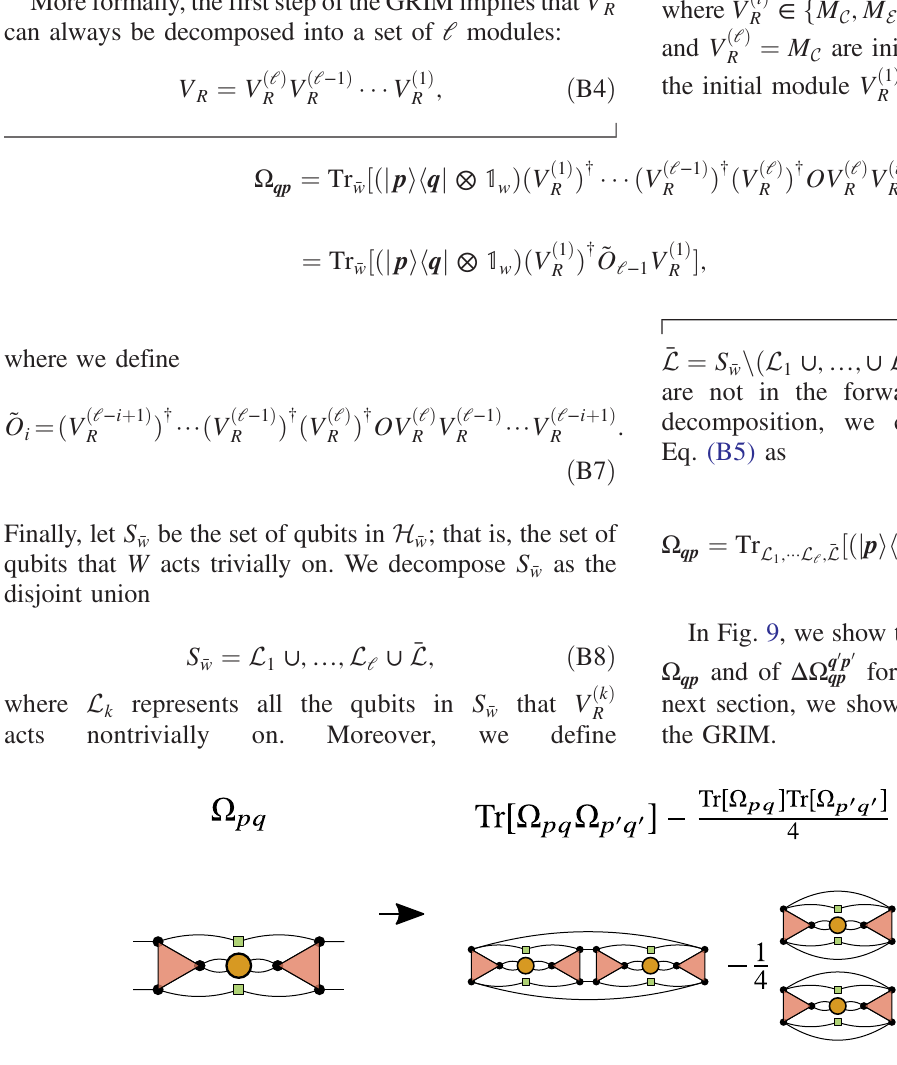
FIG. 9. Tensor network representation of Ω